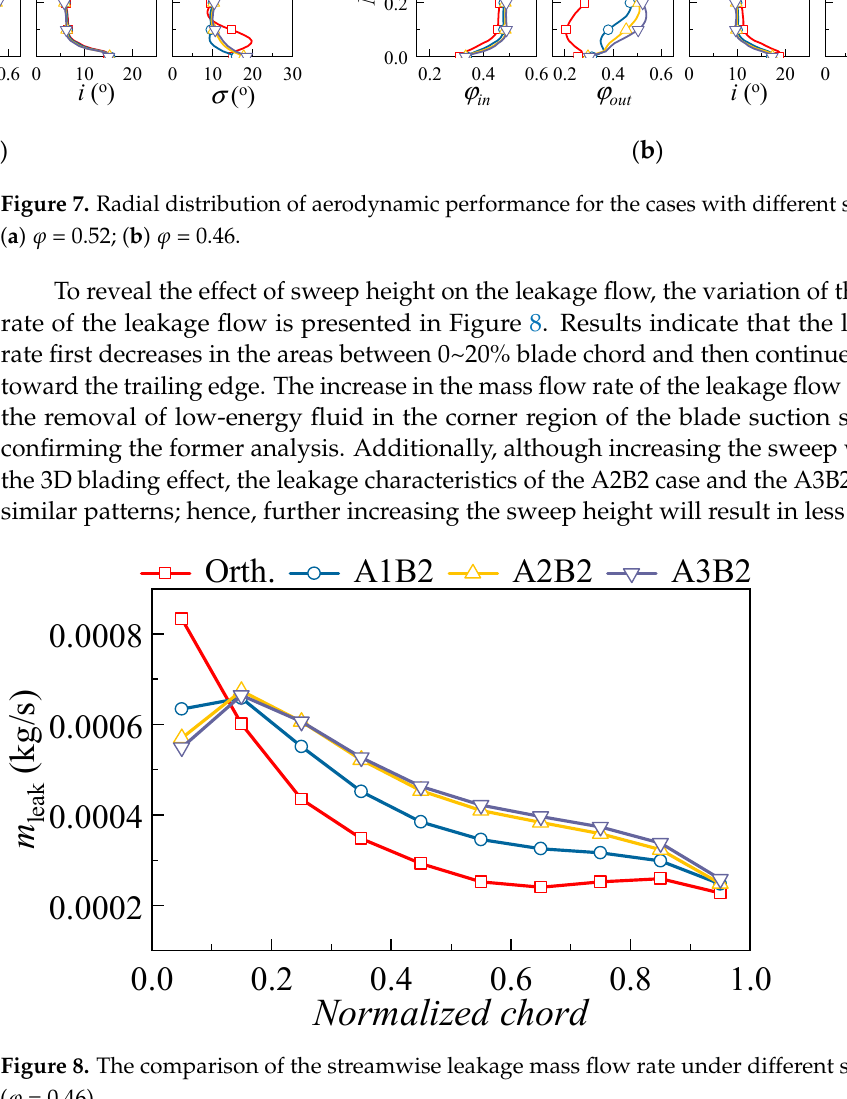
Figure 7. Radial distribution of aerodynamic performance for the cases with different sweep heights.